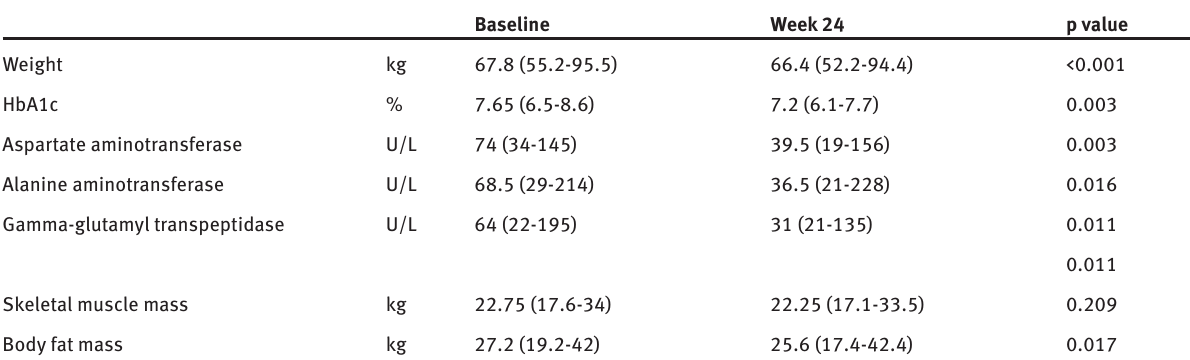
Table 3: The effect of ipragliflozin in 12 patients with non-alcoholic